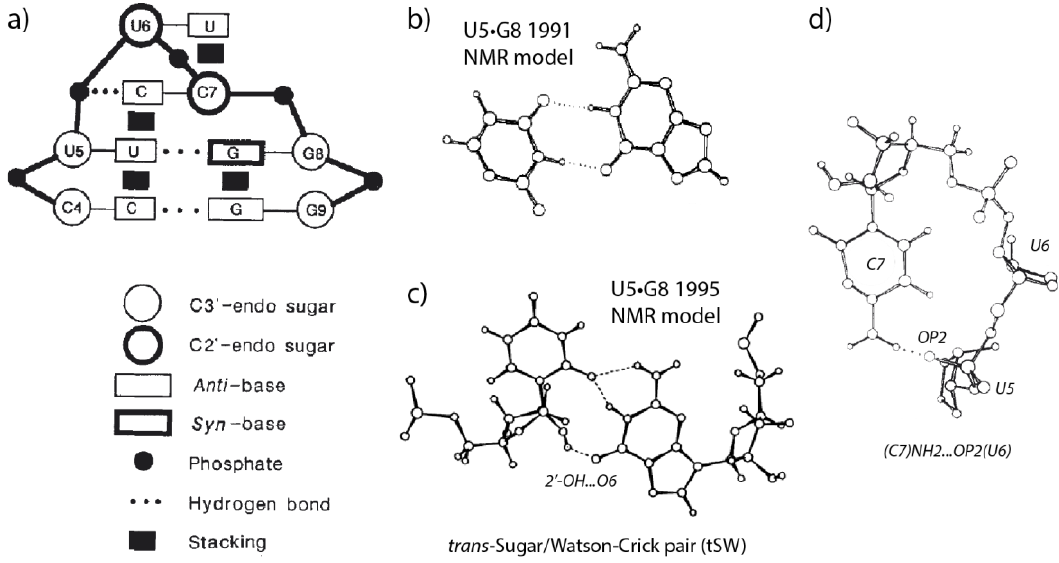
Figure 1. Early and revised r(U 5 UCG 8 ) NMR model structures. ( a ) First NMR structural